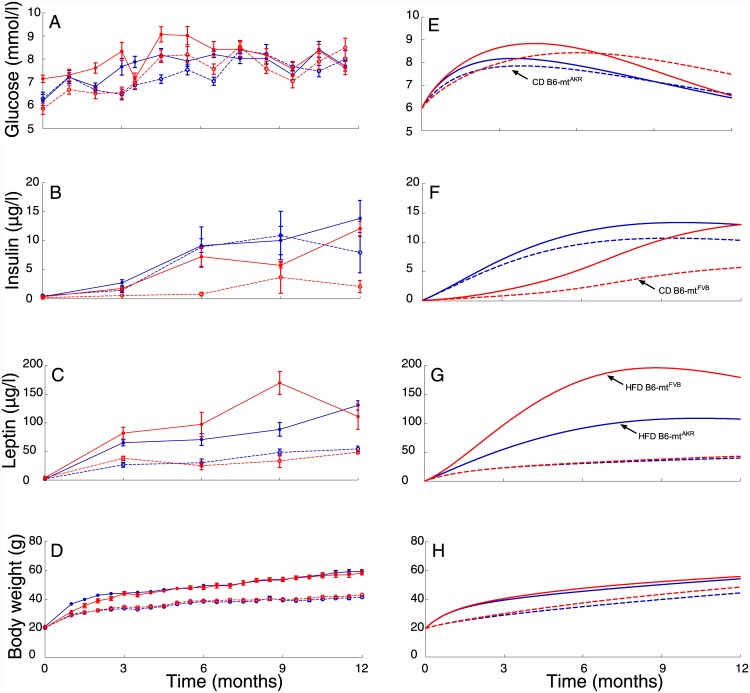
Time-courses of blood glucose, insulin, leptin and body weight in vivo and simulated.Blood glucose levels exhibited a characteristic two-peak response irrespective of diet and strain. There was a significant effect of high-fat diet (solid lines) on blood glucose response at early time points (3, 6 months of diet) in both control (B6-mtAKR in blue) and mutated (B6-mtFVB in red) strain, however with age the blood glucose levels adapted in all cases (A). Serum insulin levels were significantly lower in mutated strain under control diet (B6-mtAKR, red dashed line), while high-fat diet administration compensated for this lack of insulin by 6 months of age, which then remained elevated over 12 months of diet (red solid line) (B). Serum leptin levels were also significantly higher for mice fed high-fat diet, which further remained elevated over 12 months of diet (solid lines) (C). Mice fed with a high-fat diet had a pronounced increase in body weight (solid lines) throughout the 12 months of feeding compared to mice fed control diet (dashed lines) (D). Model simulations of respective blood glucose levels (E), serum insulin levels (F), serum leptin levels (G) and body weight (H). Shown are means + SEM from n = 8–12 mice per strain and diet.